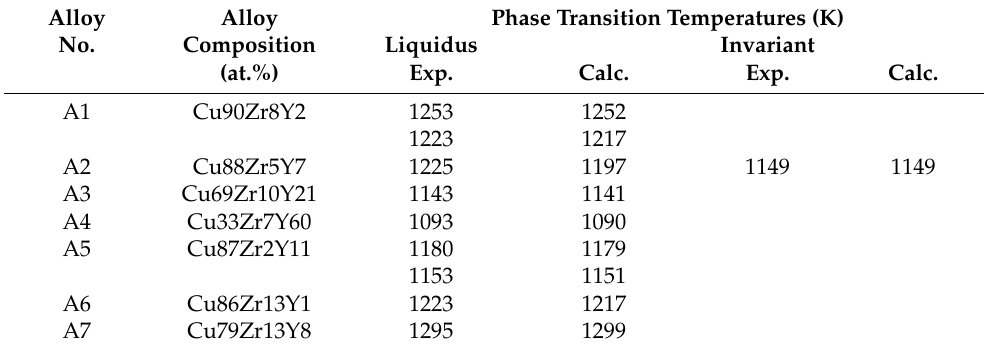
Table 2. Comparison of the DSC results with the calculated results in the Cu–Zr–Y system. Alloy Alloy Phase Transition Temperatures (K) No. Composition Liquidus Invariant (at.%) Exp. Calc. Exp. Calc. A1 Cu90Zr8Y2 1253 1252 1223 1217 A2 Cu88Zr5Y7 1225 1197 1149 1149 A3 Cu69Zr10Y21 1143 1141 A4 Cu33Zr7Y60 1093 1090 A5 Cu87Zr2Y11 1180 1179 1153 1151 A6 Cu86Zr13Y1 1223 1217 A7 Cu79Zr13Y8 1295 1299